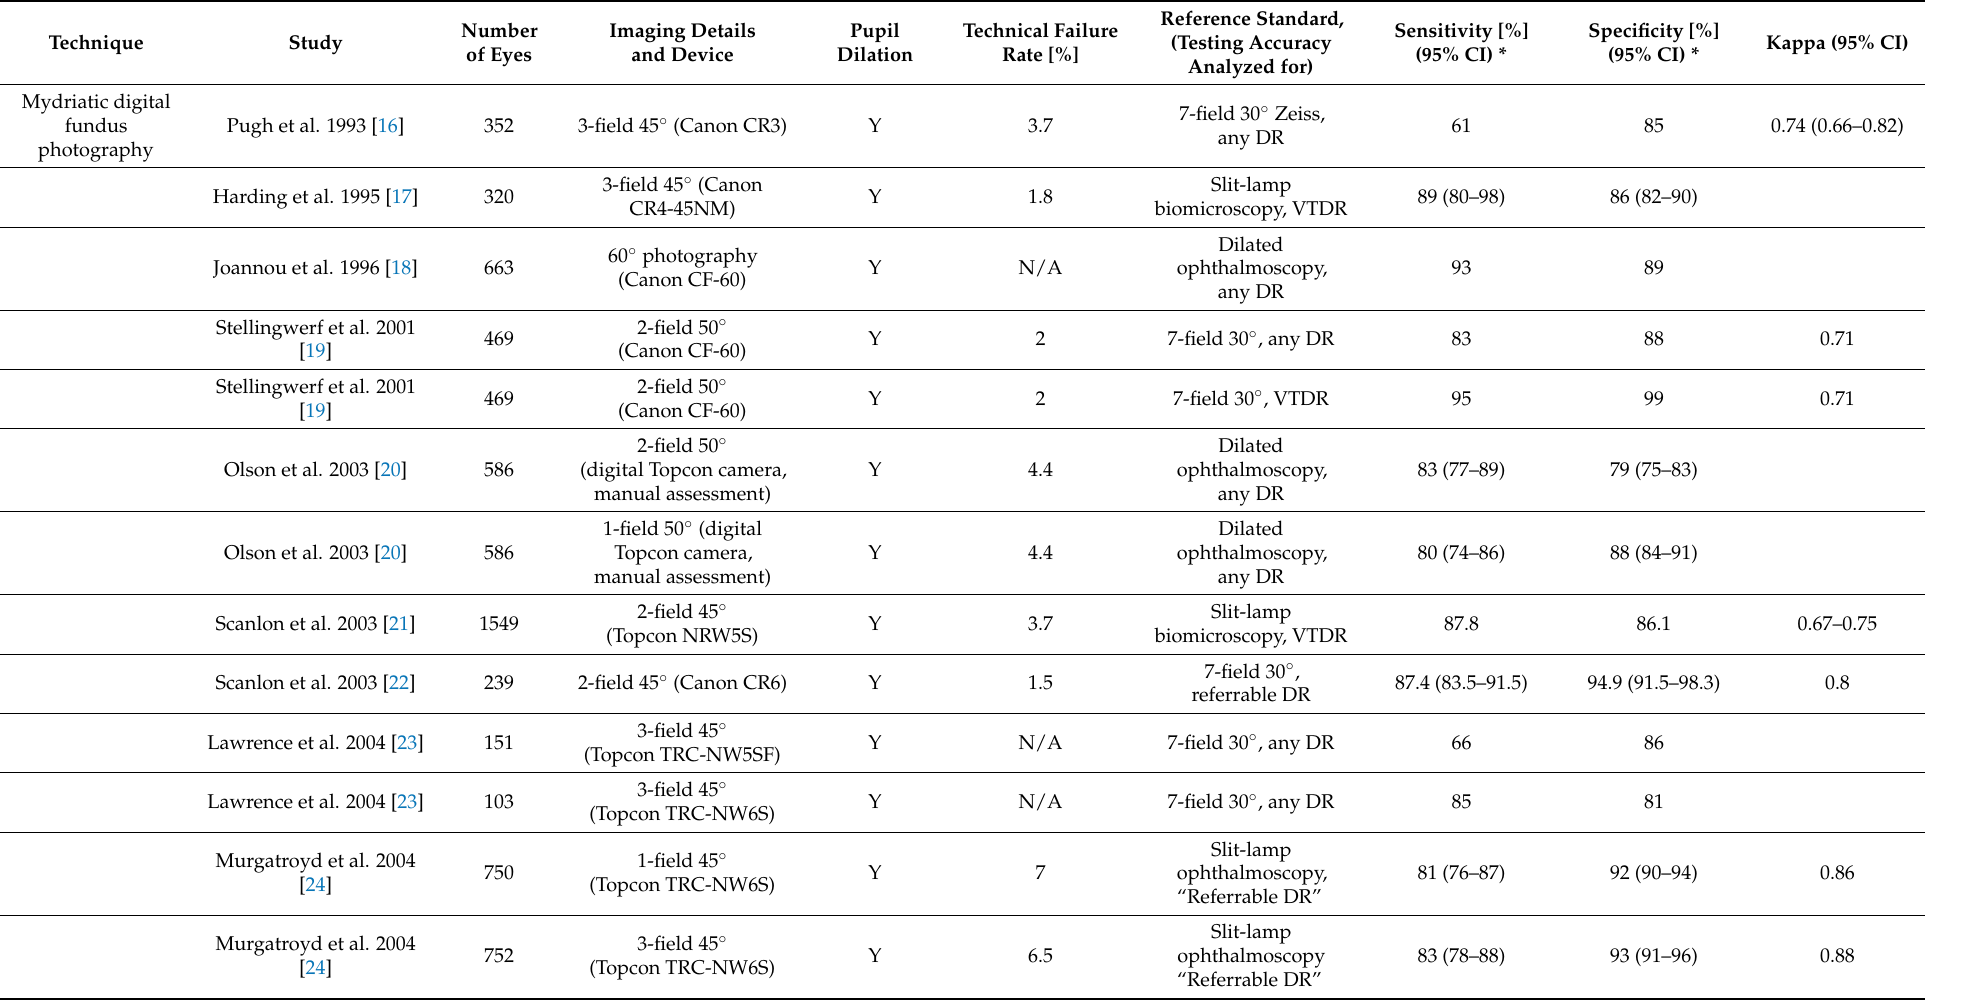
Table 1. Testing accuracy in studies on imaging modalities used for detecting diabetic